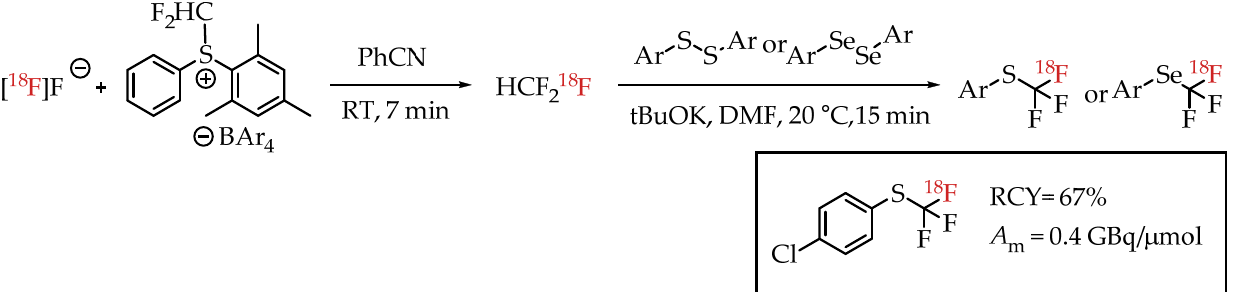
arrow indicates the tumour); (adopted from [67]; (RCY: radiochemical yield).